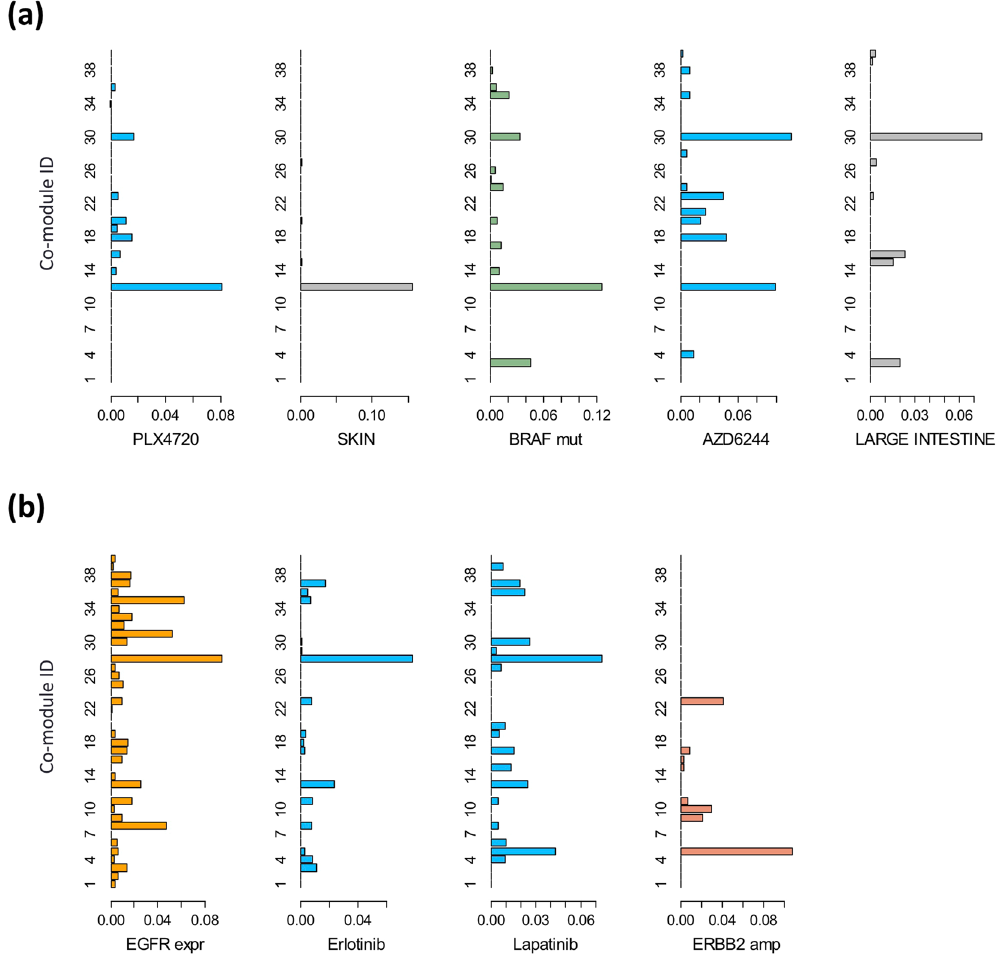
Figure 3. Differences in co-modules between compounds and related biomarkers. ( a ) Difference between sensitivity profiles to PLX4720 and AZD6244. The x-axis shows JNMF meta-profile levels and the y-axis shows 40 JNMF co-module IDs. Co-module #12 is enriched with both PLX4720 and AZD6244, and co-module #30 is an AZD6244-specific co-module. ( b ) Difference between sensitivity profiles to erlotinib and lapatinib. Co- module #28 is enriched with both erlotinib and lapatinib, and co-module #5 is a lapatinib-specific